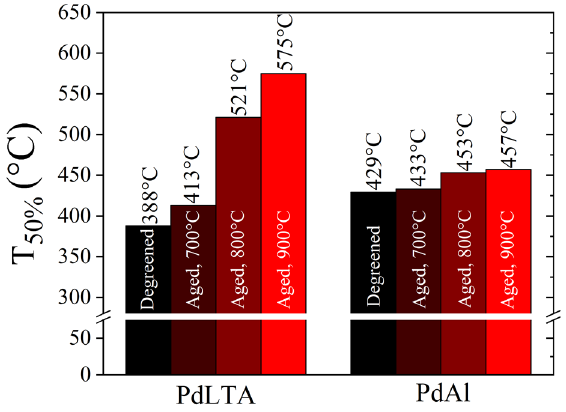
Figure 6. Temperature of 50% CH 4 conversion (T 50% ) of the temperature programmed activity test in Figure 5.